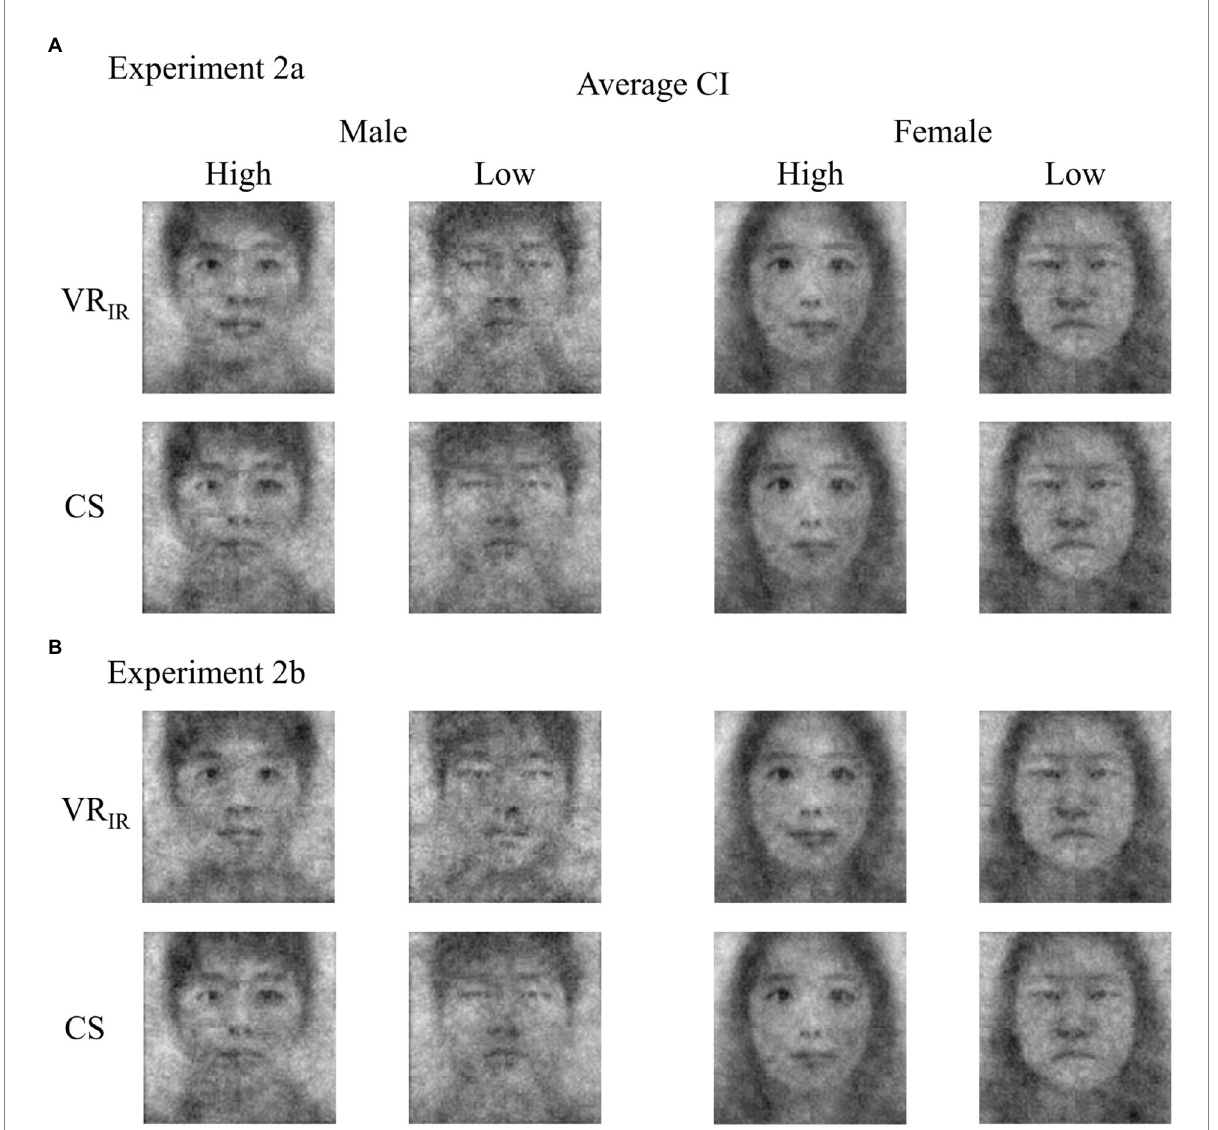
FIGURE 4 The average classification images of self (self-CIs) generated in Experiment 2a (A) and Experiment 2b (B) by high (+1 SD ) and low ( − 1 SD ) groups of independent valence ratings and of computational scores. VR IR = Valence ratings of the independent raters (self-CIs); CS = Computational scores